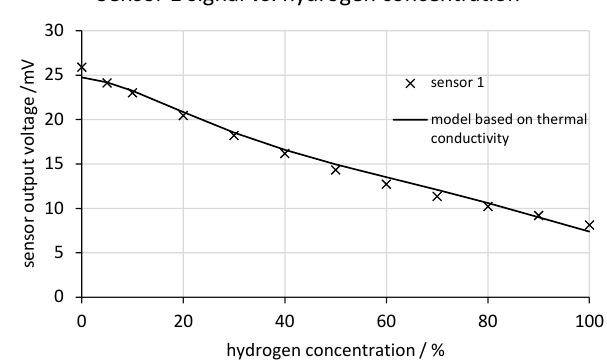
Figure 8. Comparison of the measured data with sensor 1 to a model based on Eq. (1) and literature heat conductivity values of mixtures between hydrogen and nitrogen (Mason and Saxena, 1958).